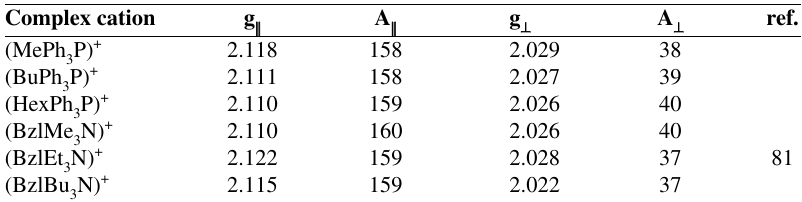
Table 4. Anisotropic EPR-parameters for the investigated Cu(II) doped bis(1,2-dithioquadrata- to)nickelates(II) (coupling constants / · 10 –4 cm –1 ). Complex cation g |||| A |||| g ⊥⊥ A ⊥⊥